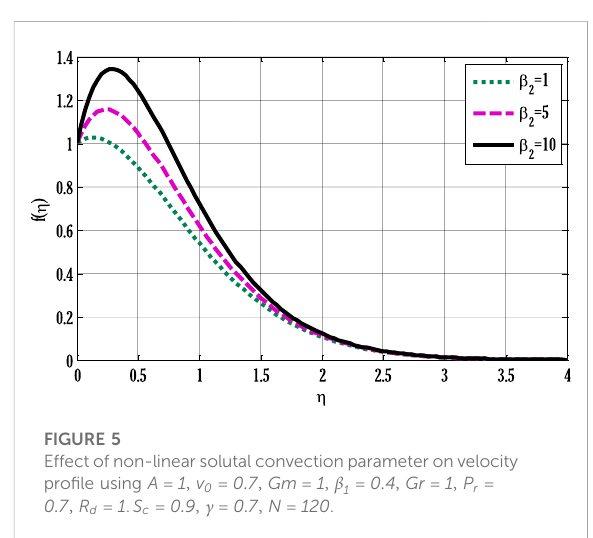
FIGURE 4 Effect of non-linear thermal convection parameter on velocity pro fi le using A (cid:1) 1 , v 0 (cid:1) 0 . 7 , Gm (cid:1) 1 , Gr (cid:1) 1 , β 2 (cid:1) 0 . 4 , P r (cid:1) 0 . 7 , R d (cid:1) 1 , S c (cid:1) 0 . 9 , γ (cid:1) 0 . 7 , N (cid:1) 120 .